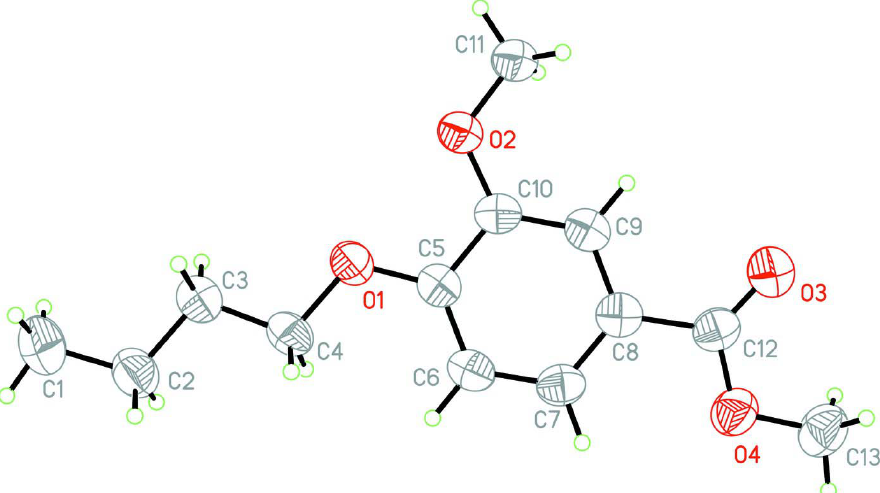
Figure 1 The molecular structure of the title molecule, with the atom-numbering